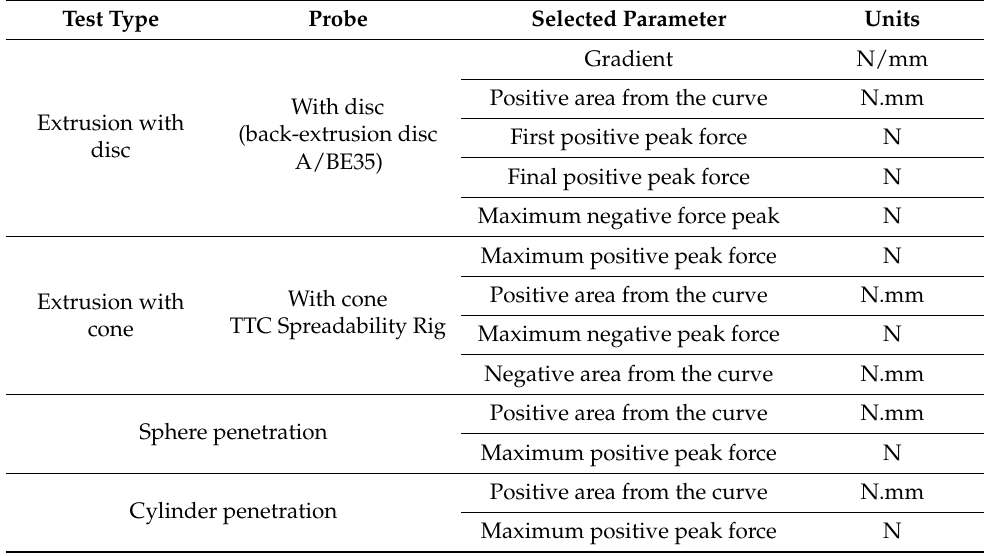
Table 3. Instrumental parameters obtained from the force–distance curves for the different